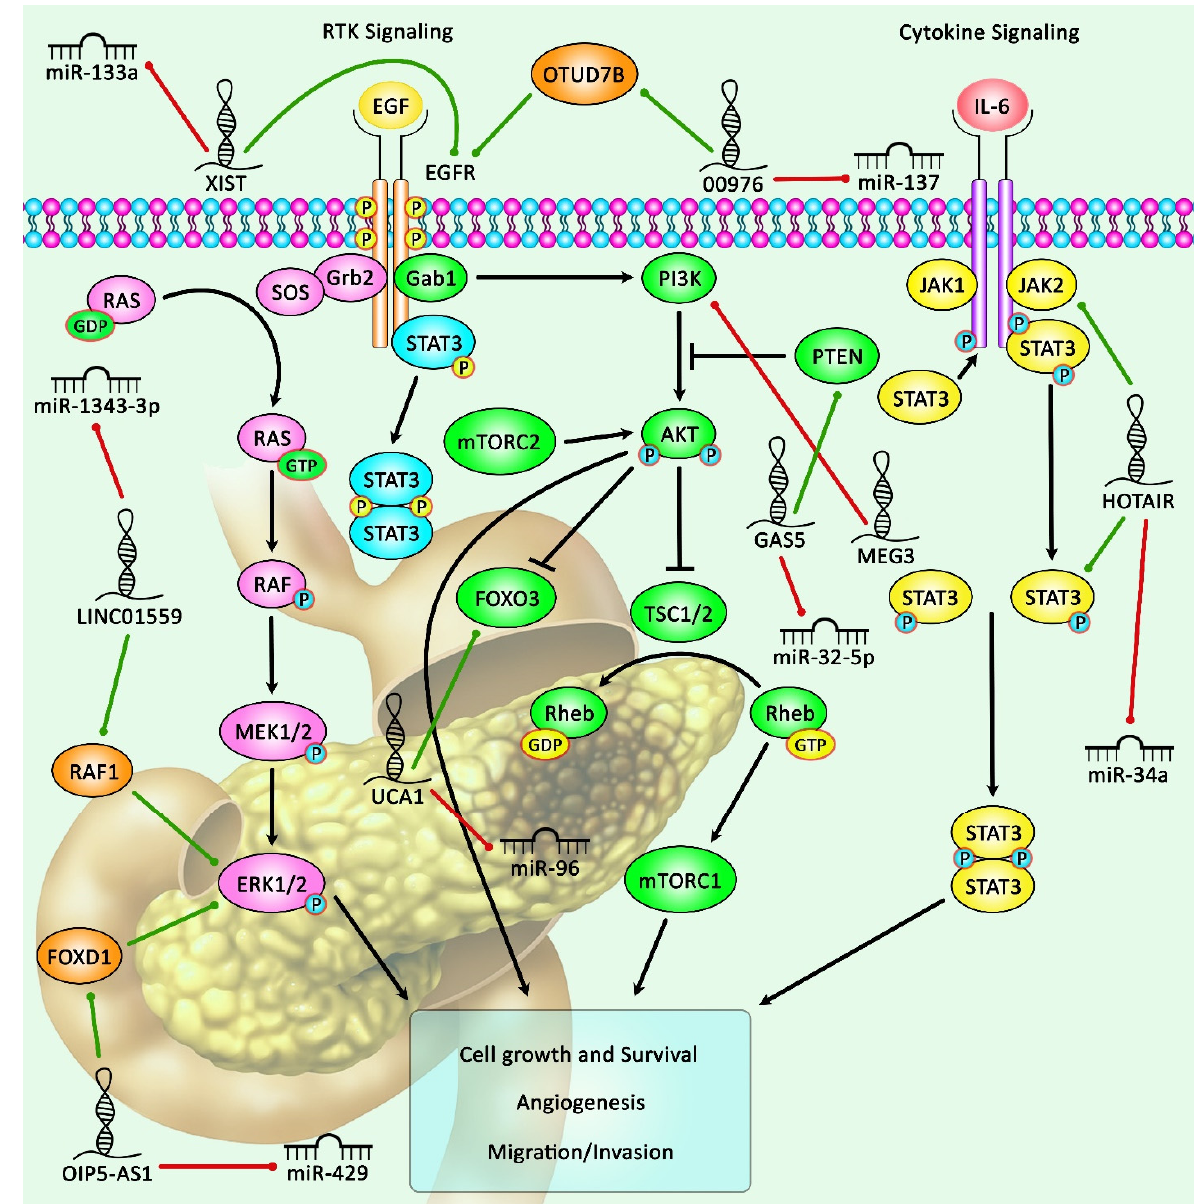
Figure 2. A schematic representation shows that several lncRNAs regulate the PI3K/AKT, MAPK/ERK and JAK2/STAT3 pathways in pancreatic cancer. Growth factor-driven RTK (e.g., EGFR) or cytokine (e.g., IL- 6) signaling can trigger the activation of PI3K/AKT, MAPK/ERK, and JAK2/STAT3 cascades. LncRNAs can affect the activity of these cascades. For instance, HOTAIR can trigger the activation of the JAK2/STAT3 pathway via down-regulating miR-34a expression, thus promoting invasion and migration of pancreatic ductal adenocarcinoma [12]. In addition, GAS5 can up-regulate PTEN expression by down-regulating the expression level of miR-32-5p, therefore inhibiting pancreatic cancer metastasis [41]. LINC01559, through sponging miR-1343-3p, can up-regulate RAF1 expression that can further activate the ERK signaling pathway, thereby enhancing pancreatic cancer progression and metastasis [15]. Green arrows indicate the up-regulation of target genes modulated via lncRNAs; red arrows depict the inhibitory effects.